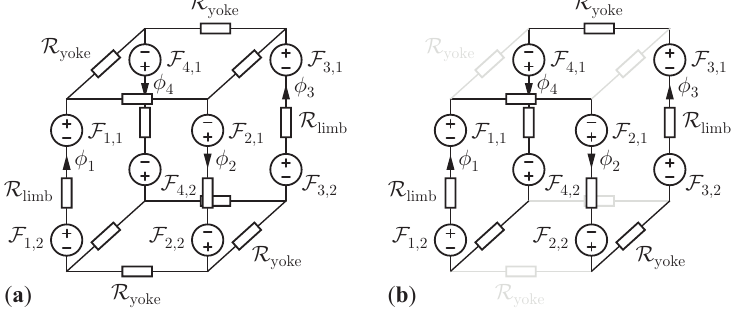
Figure 23. Magnetic circuits for ( a ) a conventional matrix transformer and ( b ) the proposed snake-core transformer, with the magnetomotive forces of the windings ( assuming the permeability of the core is sufficiently high to ignore reluctance paths through the air. The snake-core transformer has only a single path for the flux, guaranteeing identical flux through every winding and resulting in ideal current sharing. The conventional matrix transformer has multiple flux paths, and small turns or reluctance mismatches therefore result in poor current sharing and, potentially, operation